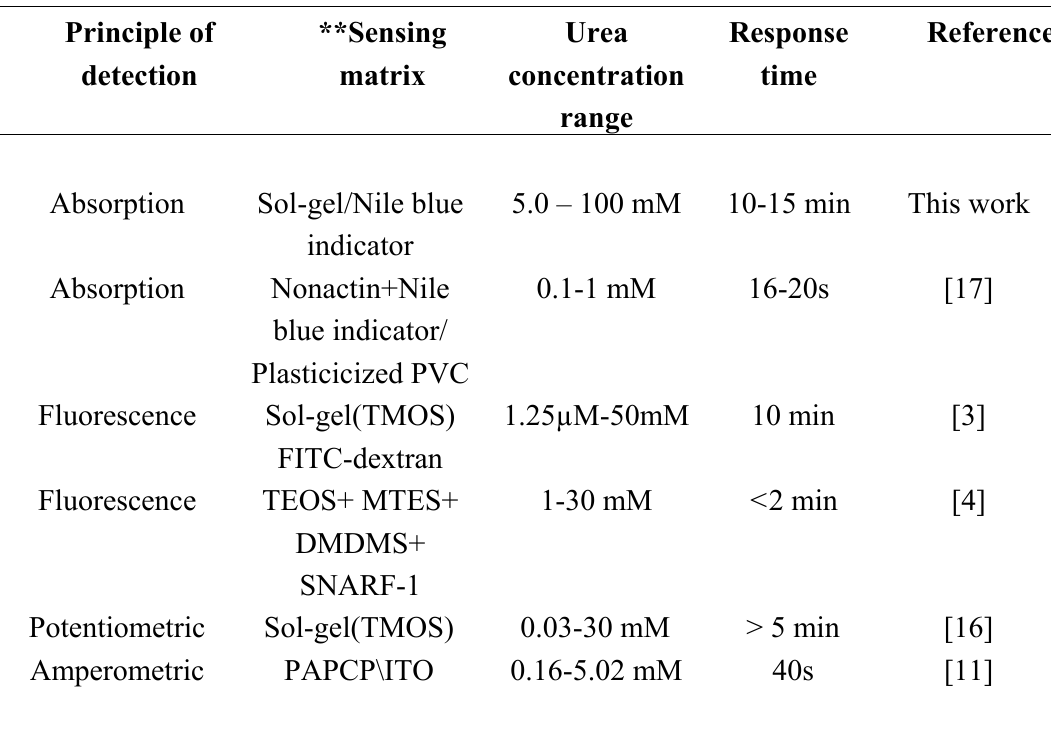
Table 4. A summary of some reported urea biosensors compared with the biosensor reported in this